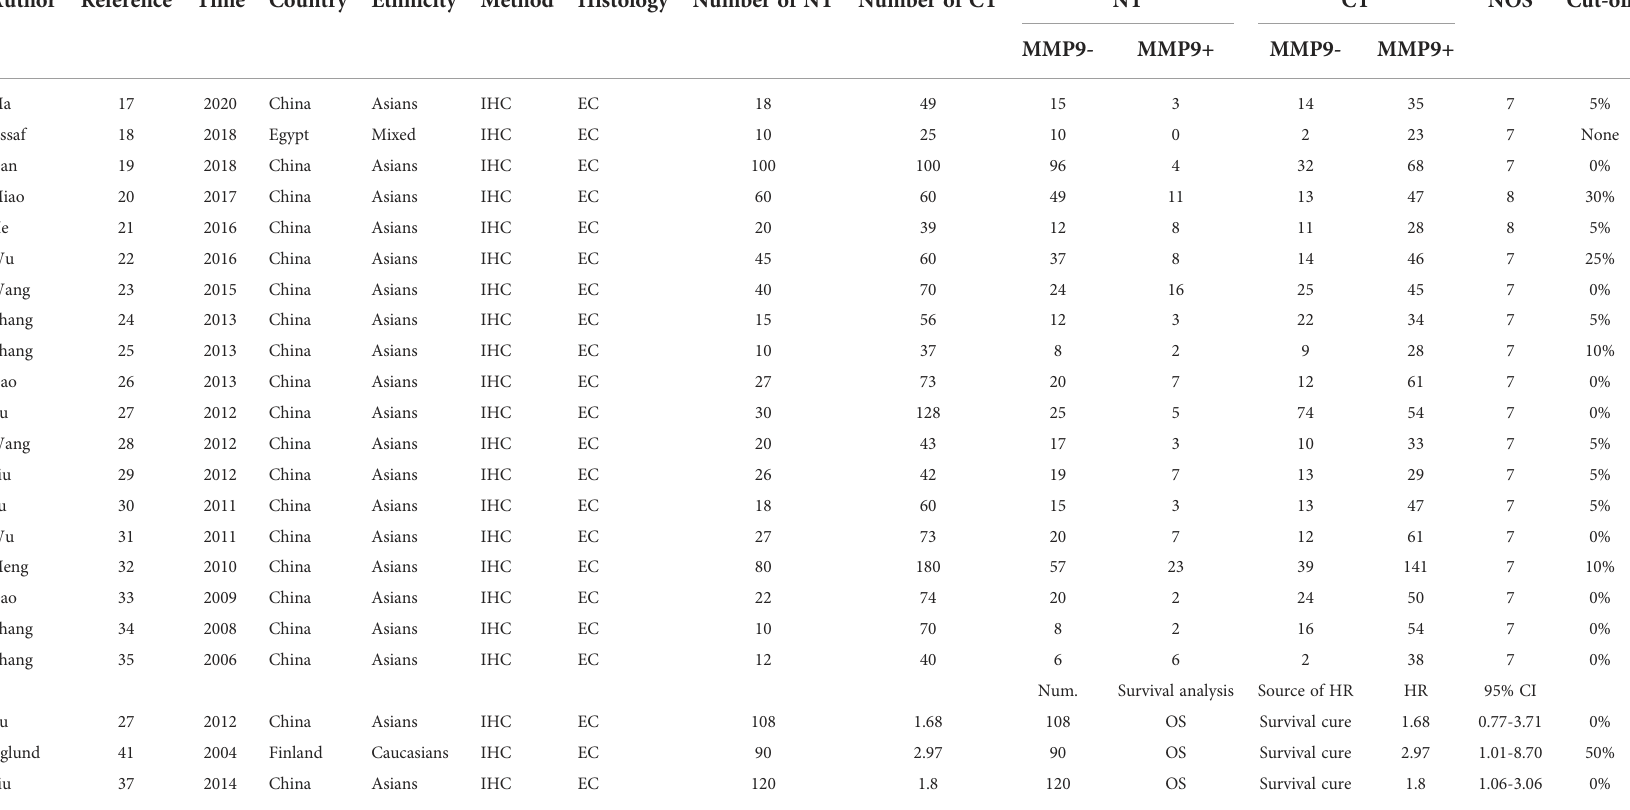
TABLE 1 Study characteristics of the included studies for the risk and prognosis of